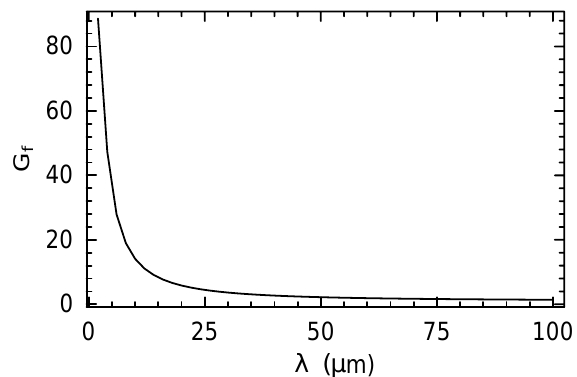
FIG. 4. Amplification factor G f as a function of wavelength for the zero beam emittance and s p (cid:1) 3.0 3 10 2 6 .